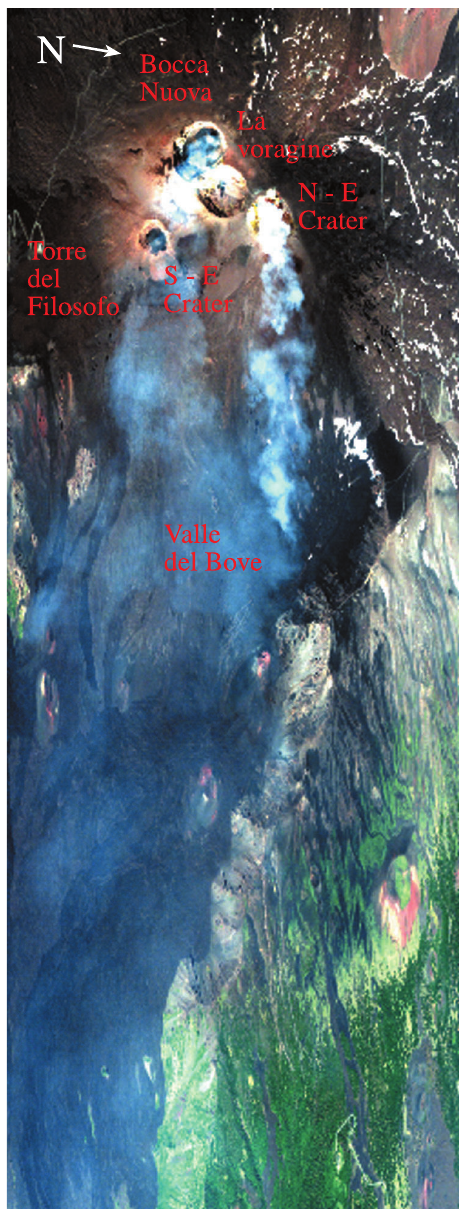
Fig. 2. MIVIS image Etna June 16th 1997 calibrated in Radiance RGB composition. Flight altitude 6000 m. Pixel resolution ranges to 4 ¥ 4 m 2 at summit craters to 11 ¥ 11 m 2 at the sea